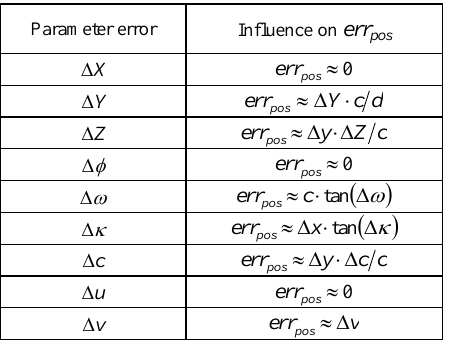
Table 1: Influence of calibration parameter errors for a